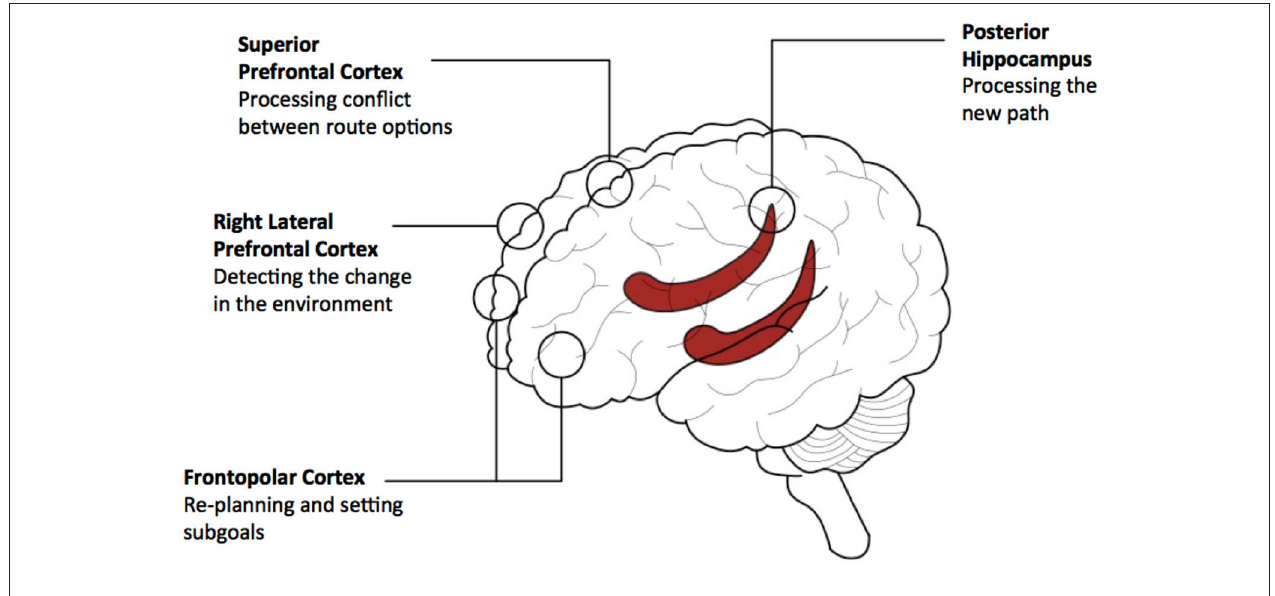
path processing in the hippocampus propagates to rostral PFC and superior PFC regions for the setting of subgoals and dealing with conflict between possible routes, respectively. Based on computational theories of PFC---hippocampal networks (e.g., Martinet et al., 2011; Hirel et al., 2013), it is predicted that activity would re-route multiple times between anterior/superior PFC regions and the hippocampal network to provide processing of alternative routes, depending on the complexity of the potential route and its